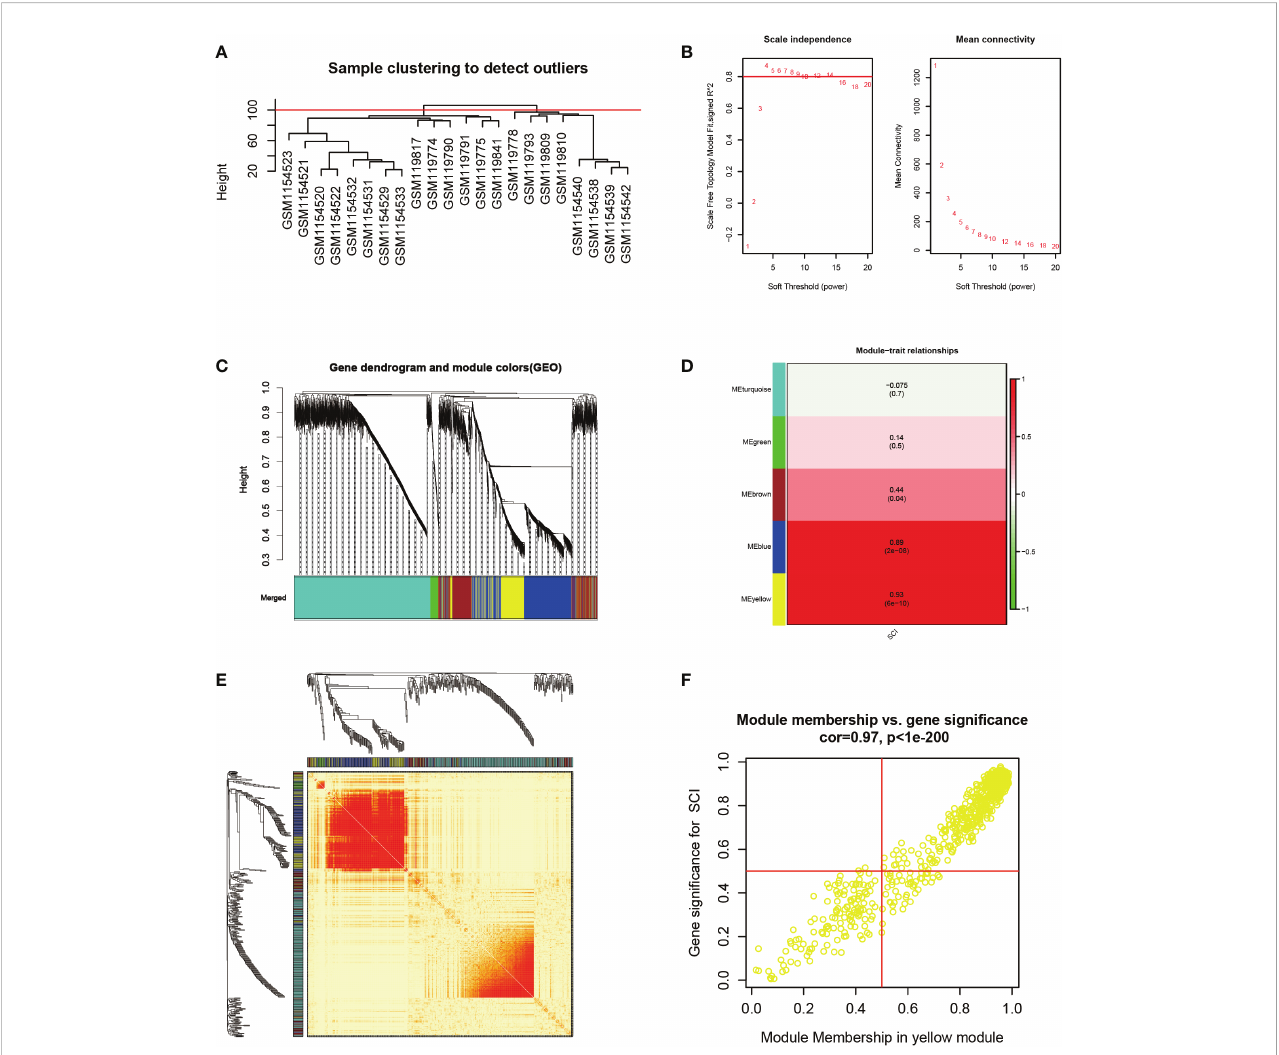
FIGURE 3 Identi fi cation of key modules genes of bulk RNA-seq datasets. (A) Outlier removal with “ h > 100 ” . (B) Soft threshold setting according to R2 = 0.80. (C) The gene set is divided into 5 different modules. (D) The correlation of modules with SCI occurrence. (E) The heatmap of correlations between modules. (F) The correlation between yellow module and SCI gene signi fi cance. Gene signi fi cance for SCI refers to compare the correlation between a gene and its corresponding traits (absence of